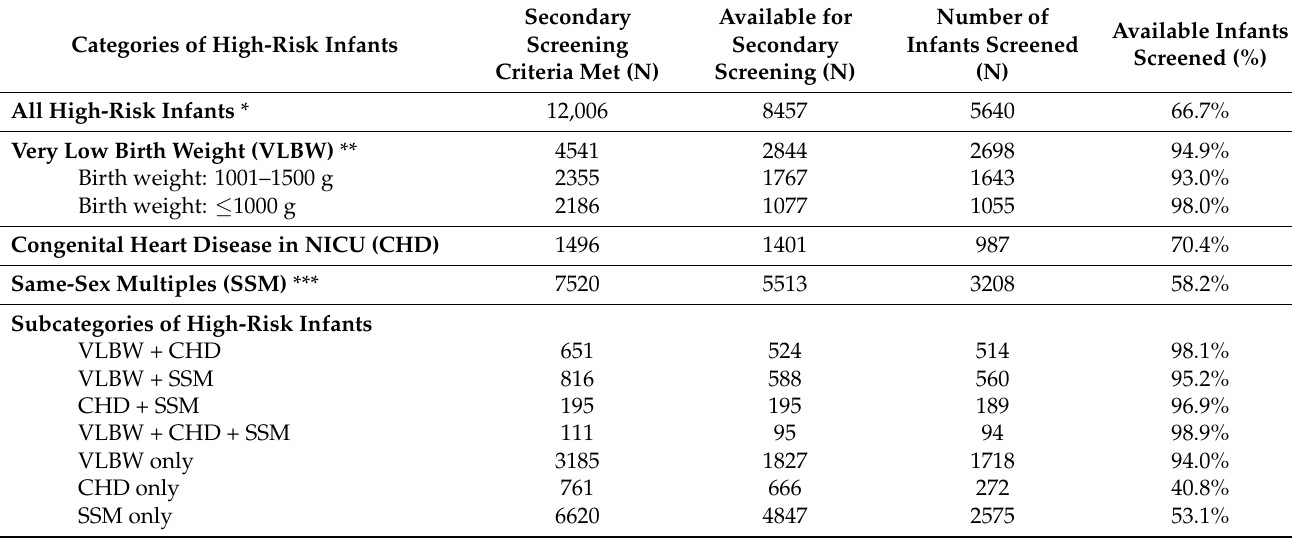
Table 2. Secondary Screen